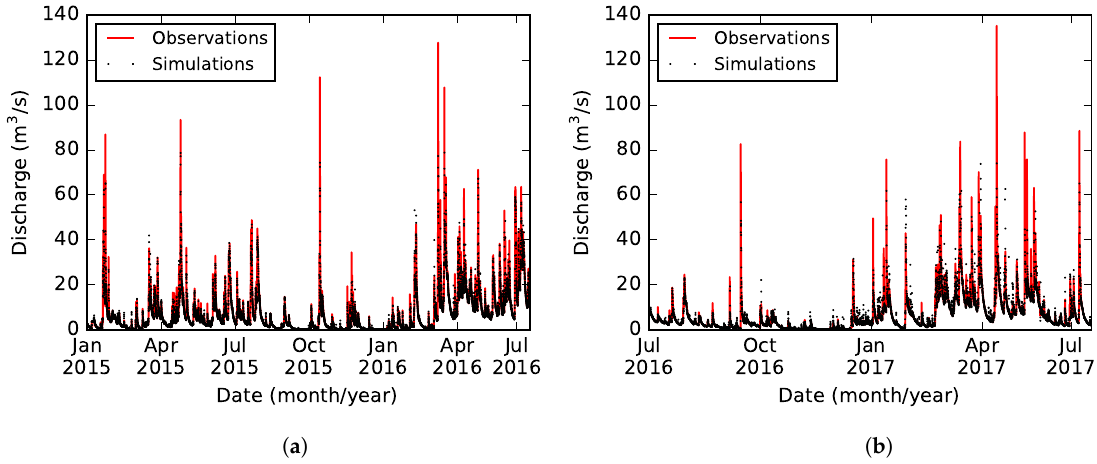
Figure 7. Model results of the parsimonious 4-h discharge forecasting (model C) ( a ) Training period, from January-2015 to July-2016. ( b ). Validation period, from July-2016 to